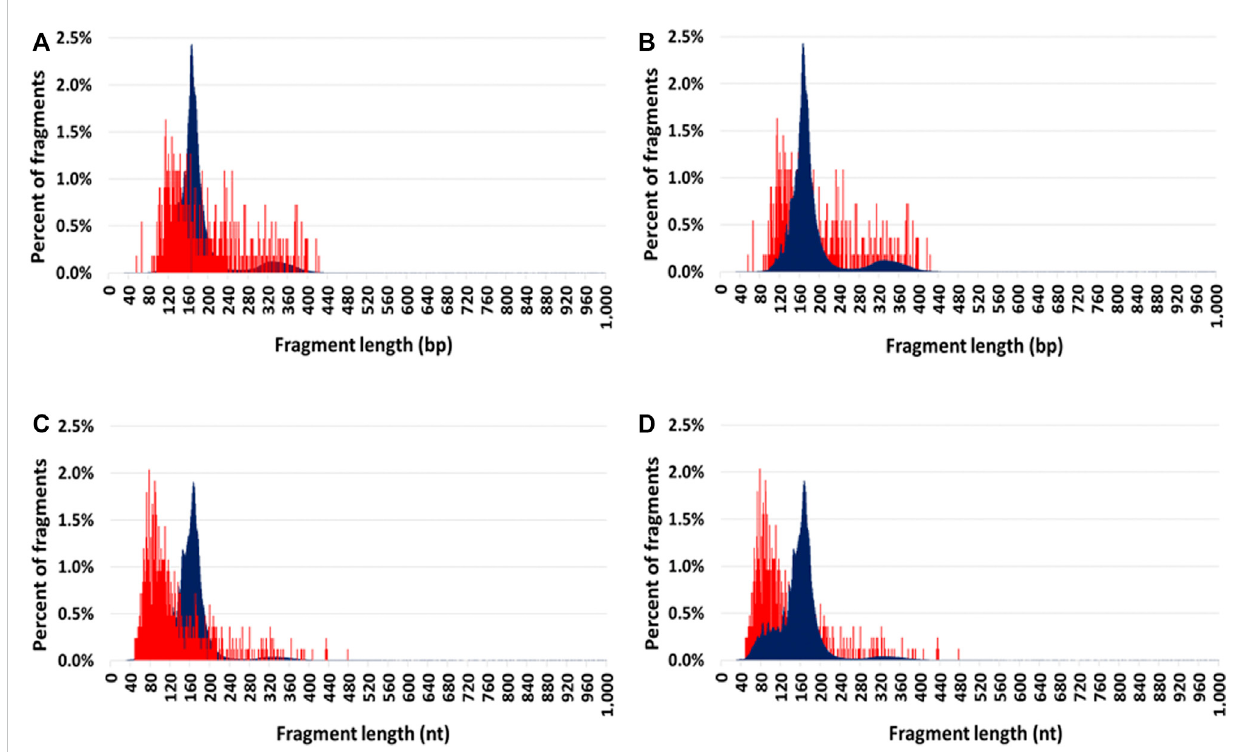
FIGURE 2 Comparison of the mean size pro fi les of circulating mitochondrial DNA (cir-mtDNA) and circulating nuclear DNA (cir-nDNA) from seven healthy individuals with alternate foreground. Low-pass WGS mean size pro fi les of cir-mtDNA (red) and cir-nDNA (dark blue) obtained with DSP-sequencing (A,B) and SSP-sequencing (C,D) : cir-mtDNA in foreground and cir-nDNA in background (A,C) ; cir-mtDNA in background and cir-nDNA in foreground (B,D)